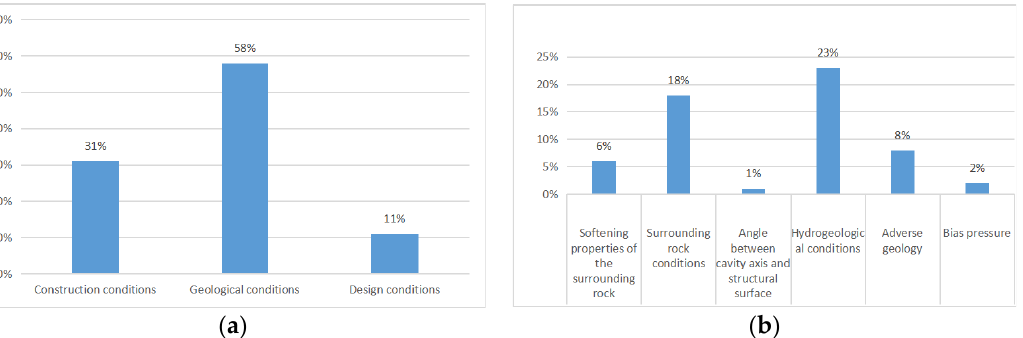
Figure 1. Stability factors in mountain tunnels. ( a ) Factors influencing structural stability. ( b ) Factors influencing geological conditions.